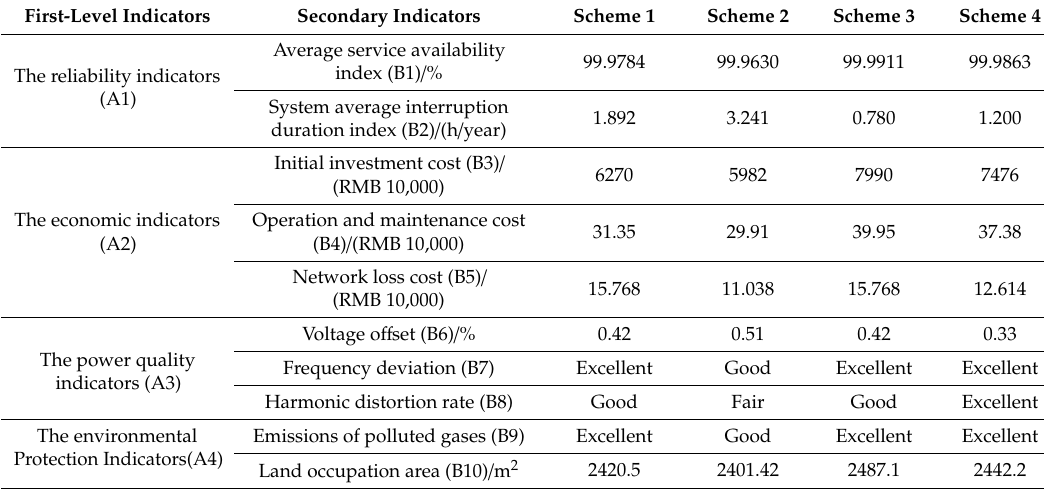
Figure 3. Power grid structure diagram. Table 4. Scheme parameters.